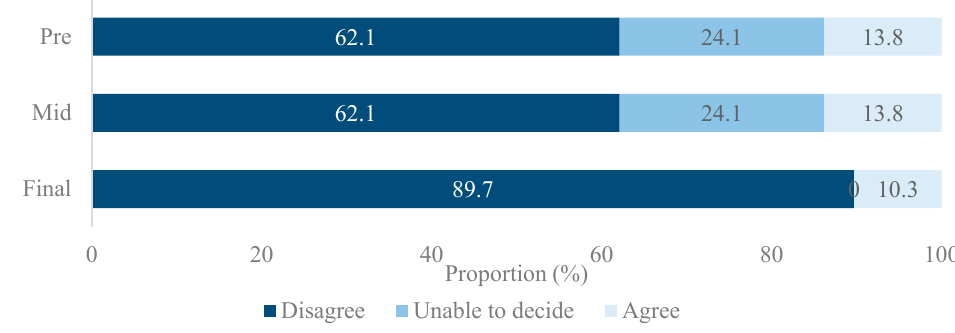
Figure 1. The proportion of jurors who disagreed not to limit the number of implants to be covered in pre-, mid-, and final survey.